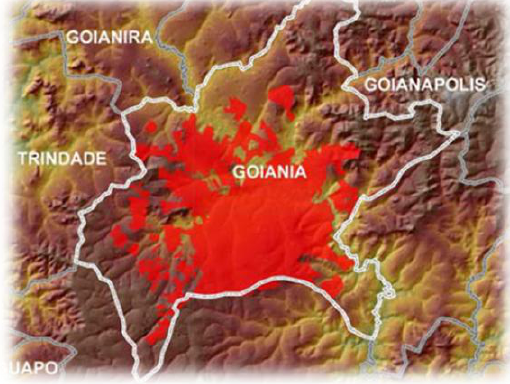
Figure 1 – City of Goiânia, Brazil. Urban area appears in red